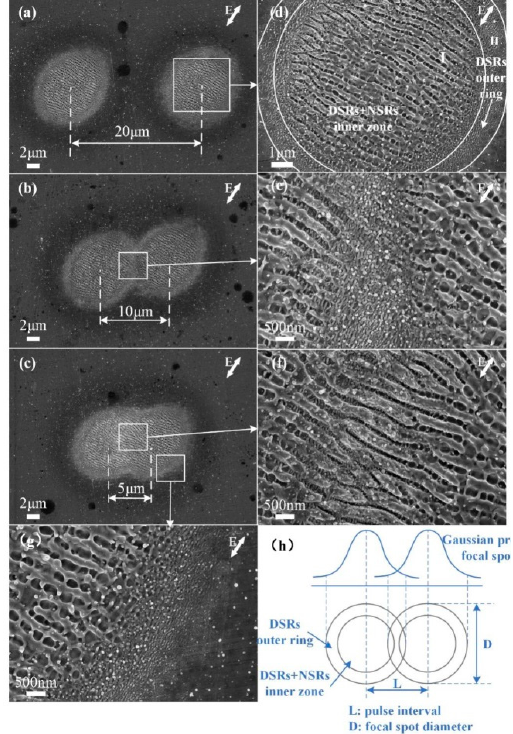
Figure 2. Scanning electron microscope (SEM) images of ps laser induced surface subwavelength ripples. Each of spot was carried out by 4 pulses with single pulse energy of 1.9 μ J and the hatch distance of the two spots was set as: ( a ) 20 μ m, ( b ) 10 μ m and ( c ) 5 μ m. ( d – g ) The corresponding images of magnified areas separately. ( h ) The schematic of peak power density profile correlation with laser spots.